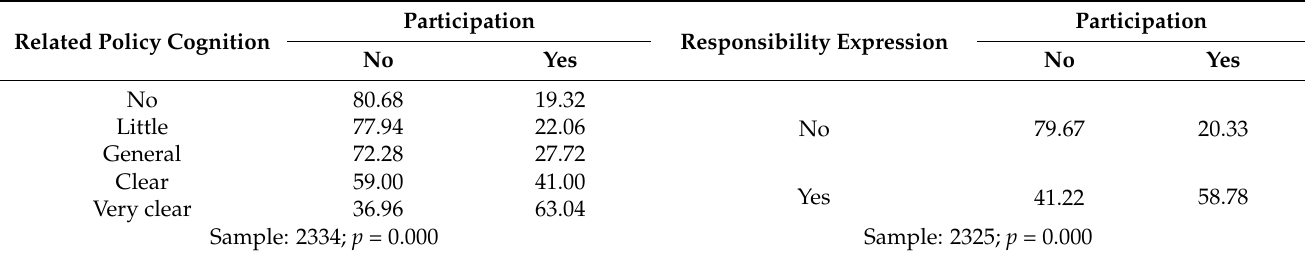
Table 3. Correlation analysis between the cognition and participation in rural health governance (Unit: %,